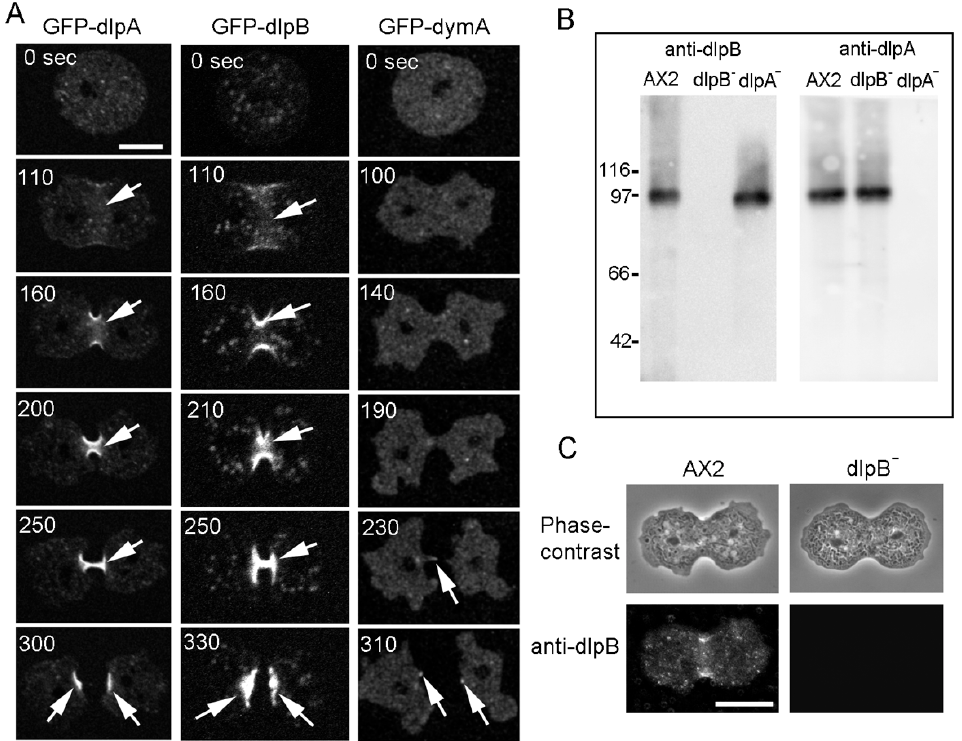
Figure 2. Three dynamins localize at the cleavage furrow. ( A ) Typical time courses of live images of GFP-dlpA, GFP-dlpB, and GFP-dymA during cell division. GFP was tagged to the C-terminus of each dynamin. Both GFP-dlpA and GFP-dlpB localized at the furrow from the initiation of furrowing to the final separation (arrows). On the other hand, a small amount of GFP-dymA localized at the connecting thread during the final separation. These observations were confirmed in at least 50 dividing cells for each cell line. ( B ) Western blots of whole-cell lysate of each cell line were probed with anti-dlpB and anti-dlpA antibodies. ( C ) Typical phase-contrast and immuno-fluorescence images of A × 2 and dlpB - cells stained with anti-dlpB antibody. Bars, 10 µm.